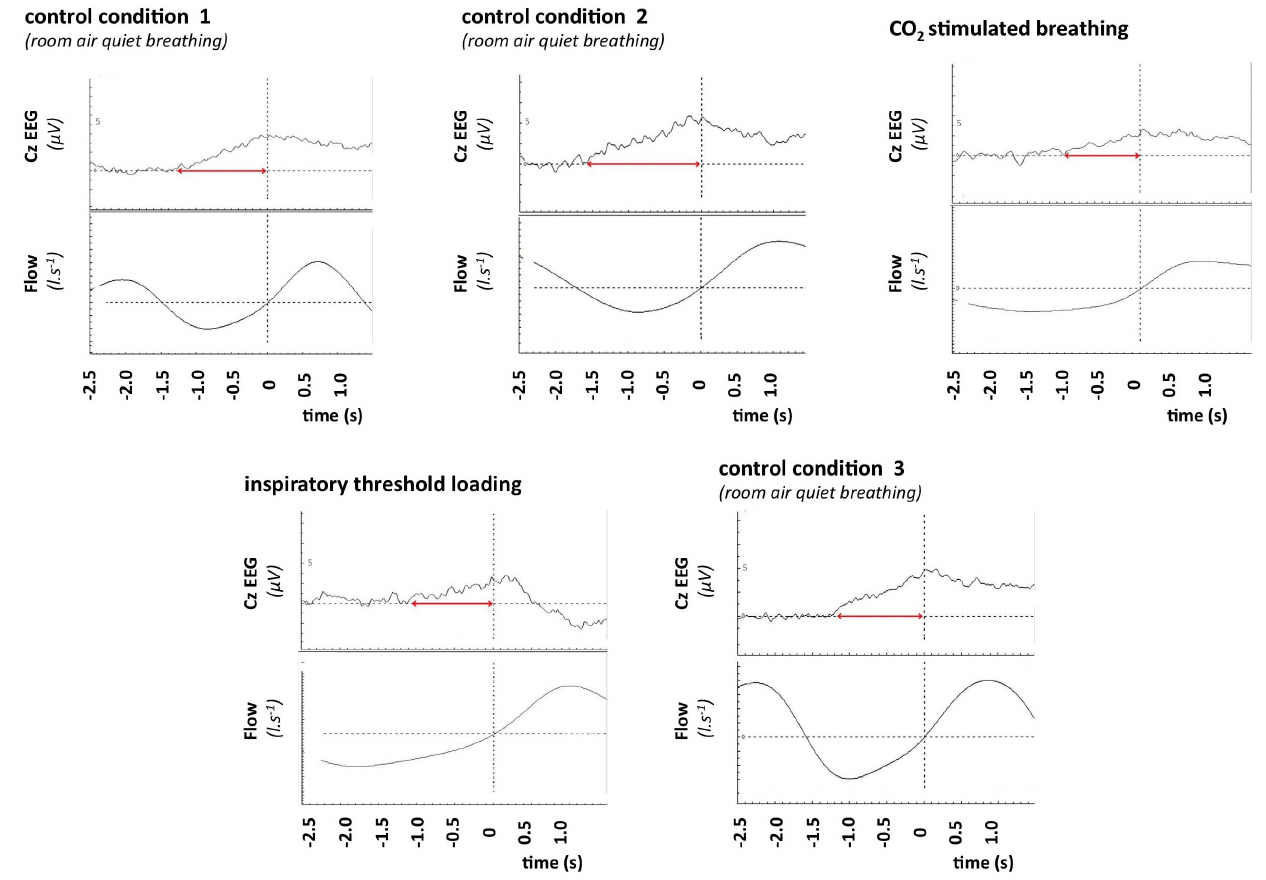
Figure 3. Average pre-inspiratory EEG tracings in one of the congenital central hypoventilation syndrome patient. In each of the panels, the top trace depicts the Cz-EEG signal, and the bottom trace depicts ventilatory flow. The vertical line indicates the onset of inspiration. In the ‘‘inspiratory threshold loading’’ panel, inspiration is preceded by a shift upward of the EEG trace (horizontal double arrowed red line) that is characteristic of a pre-inspiratory potential. This observation is similar to that made in normal individuals [12]. In contrast to normal individuals however, a pre-inspiratory potential can also be seen, abnormally, in the three ‘‘control condition’’ panels (control 1: resting ventilation with minimal constraint, namely a respiratory inductance plethysmography vest only; control 2: resting ventilation while breathing through a pneumoatchograph; control 3: as control 2, but during the washout period following inspiratory loading) and in the ‘‘CO 2 stimulated breathing’’ panel.